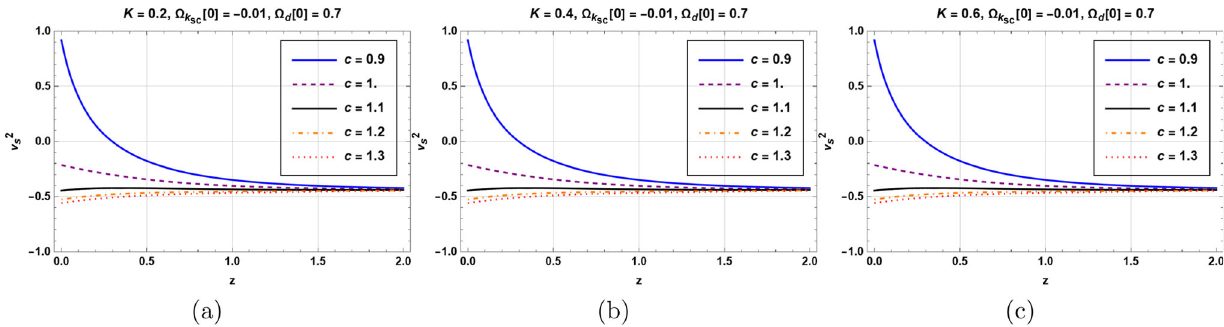
Fig. 8 The variation in the squared sound speed v 2 s with redshift z for the open universe, in units when M 2 p = 1 , H 0 = 67 . 9. In order to be consistent with data, we now imposed (cid:2) d ( x = − ln ( 1 + z ) = 0 ) = (cid:2) d [ 0 ] = 0 . 7